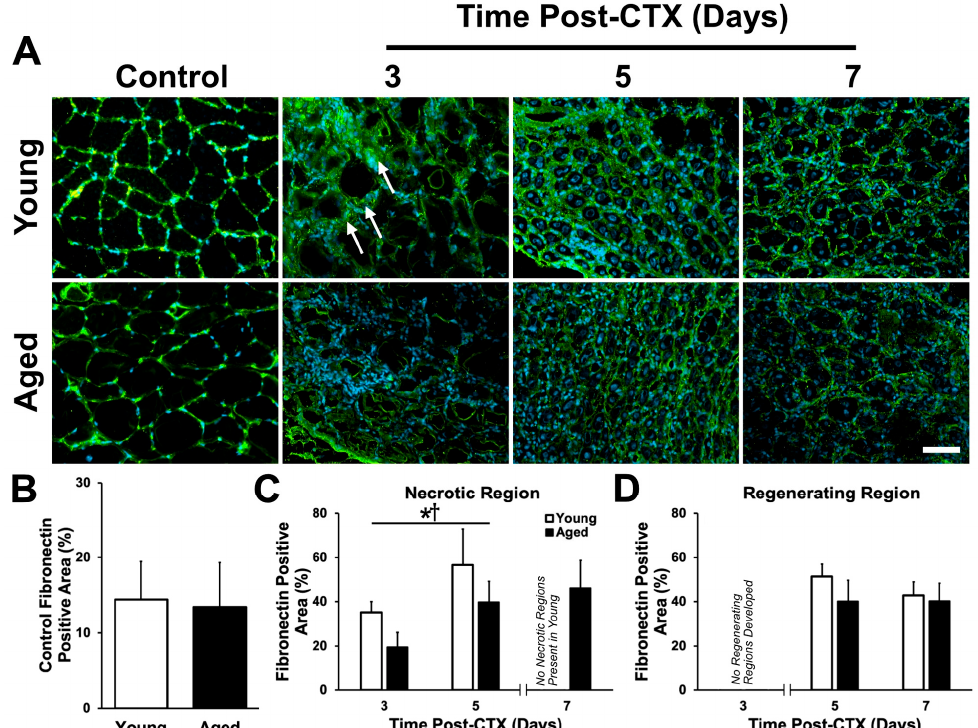
Figure 6. Fibronectin content is acutely greater in the necrotic region of young muscle. ( A ) Immunostaining of fibronectin (green) and DAPI (blue) at each time point following damage. Arrows denote regions of broad fibronectin at three days post-CTX in young muscle. ( B ) Fibronectin positive area in the undamaged control TA was not significantly different between young and aged (t-test: p = 0.256). ( C ) Fibronectin content increases over time from three to five days following damage in the necrotic region. Additionally, fibronectin was greater in the young groups during these acute time points. * denotes a significant main effect of age ( p = 0.002). † denotes a significant main effect of recovery time point following damage ( p < 0.001). ( D ) No statistically significant changes were observed in fibronectin content in the regenerating region of young and aged muscle. Note that the seven-day time point in the necrotic region and the three-day time point in the regenerating regions were not used in the statistical analysis due to insufficient instances of those regions depending on age and time point. n = 4–5 per group. Data presented are means ± standard deviation. Scale bar represents 50 μ m.